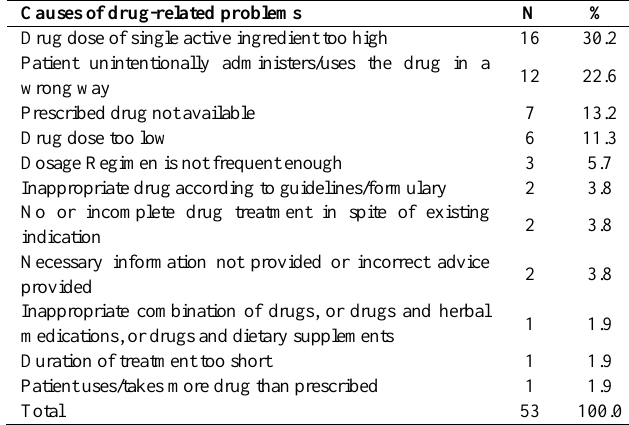
Table 2 : Types and causes of identified drug-related problems Causes of drug-related